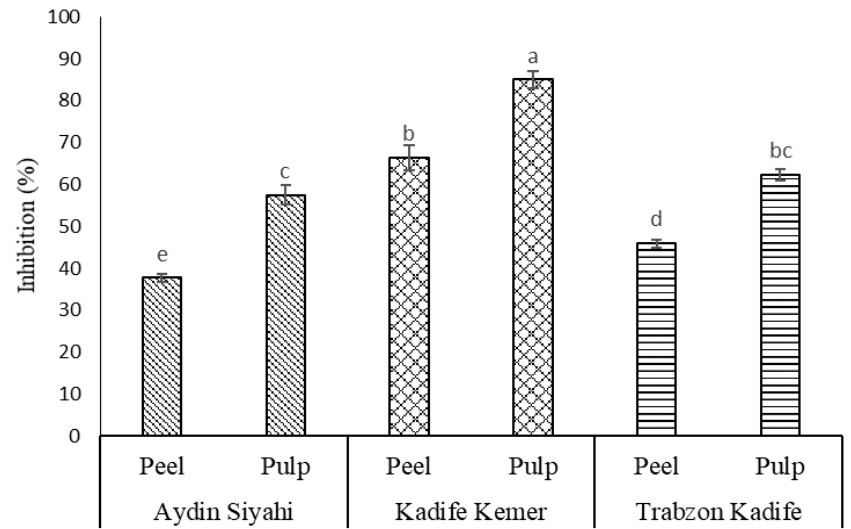
Figure 2. A comparison of α -amylase inhibition activities of crude phenolic extracts in fruits of common eggplants. Acarbose was used as a positive control (IC 50 = 0.0914 ± 0.0076 mg/mL). Values are the means ± SD of three independent experiments. Values represent the mean ± SD of three independent extractions and determinations. An analysis of variance (one-way ANOVA) was used for comparisons. In each column, different small letters indicate significant differences ( p <